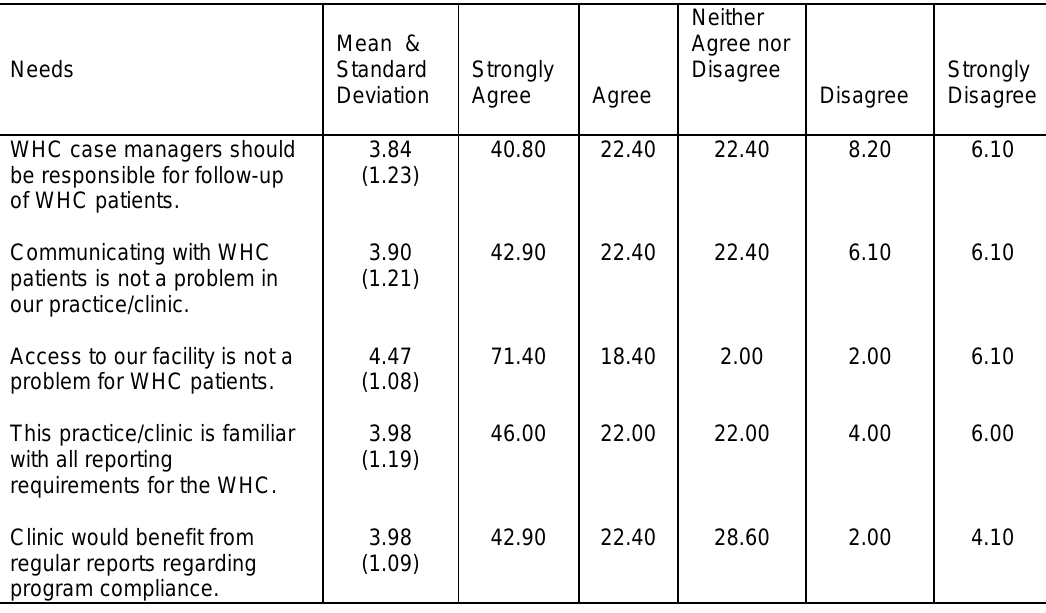
Assessment of Physicians’ Needs in the Nevada WHC